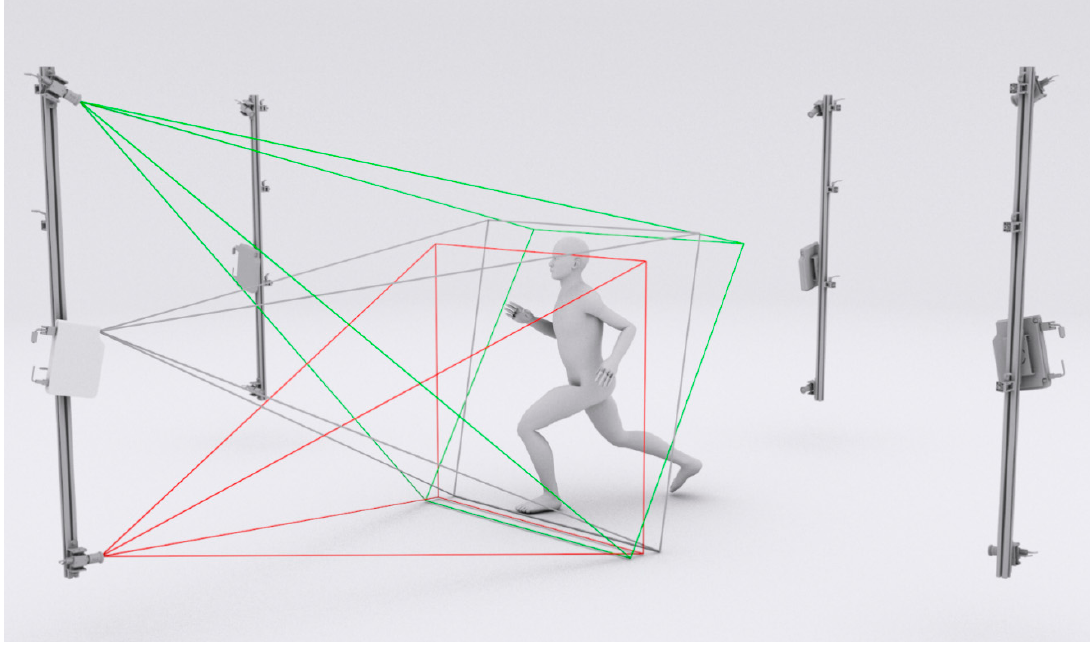
Figure 1. Architecture of the proposed acquisition system.